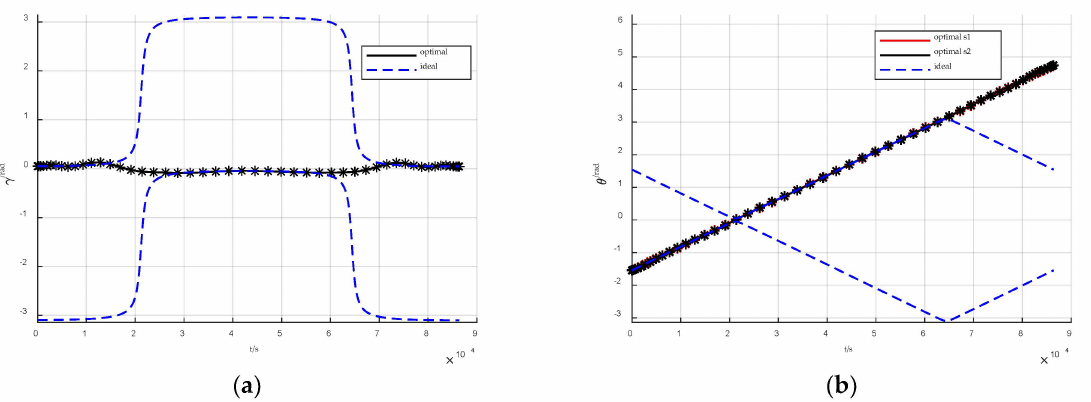
Figure 5. Angular trajectory around equinox. ( a ) Angular trajectory of γ ; ( b ) angular trajectory of θ j